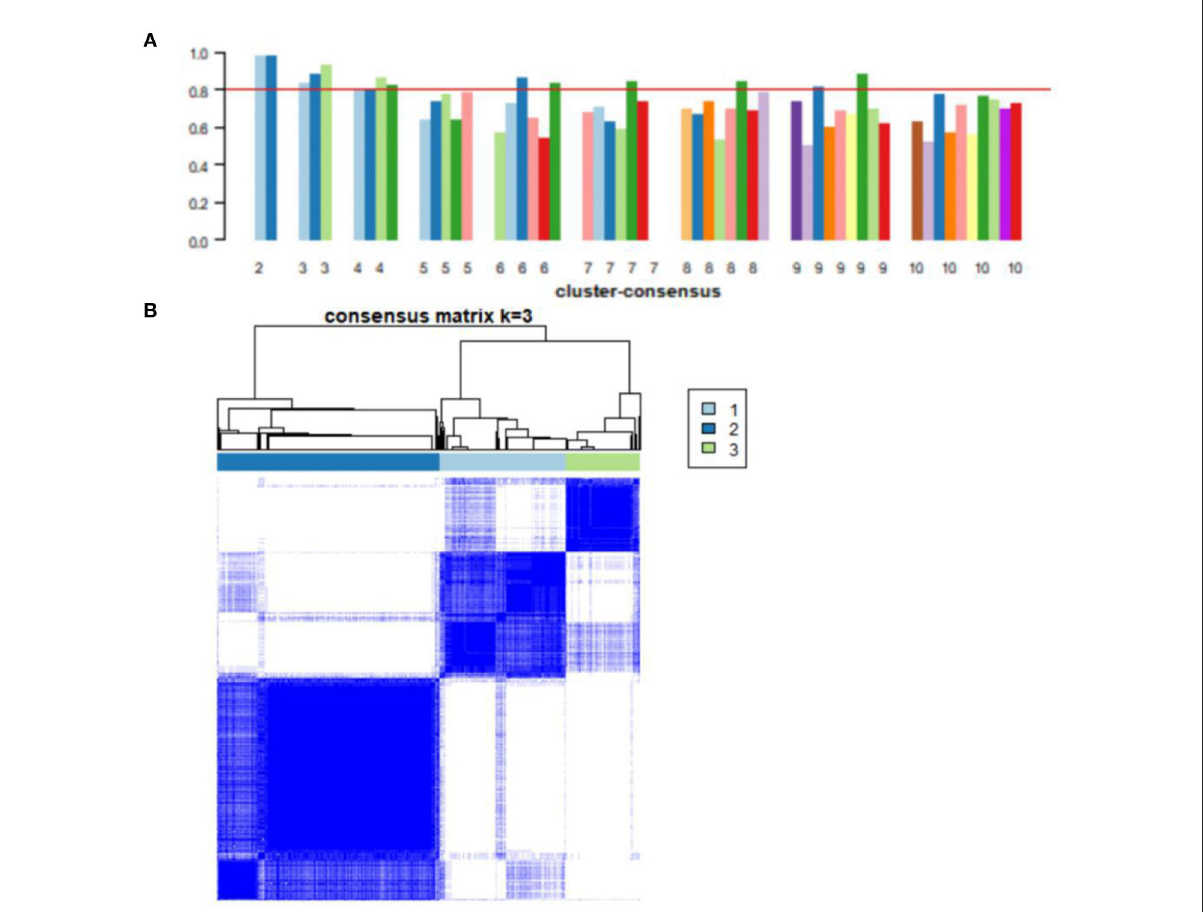
FIGURE4 Consensus clustering analysis of gene expression profiles for AD samples. (A) The bar plots represent the consensus scores for subgroups with cluster counts ranging from 2 to 10. Cluster count was most stable in three subgroups, and consensus scores for subgroups > 0.8. (B) The heat map represents the consensus matrix with a cluster count of